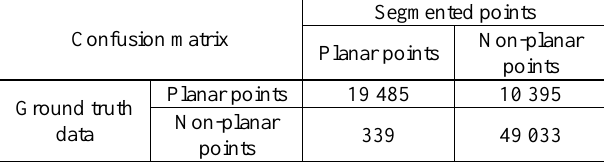
Table 9. Confusion matrix of results of the proposed method